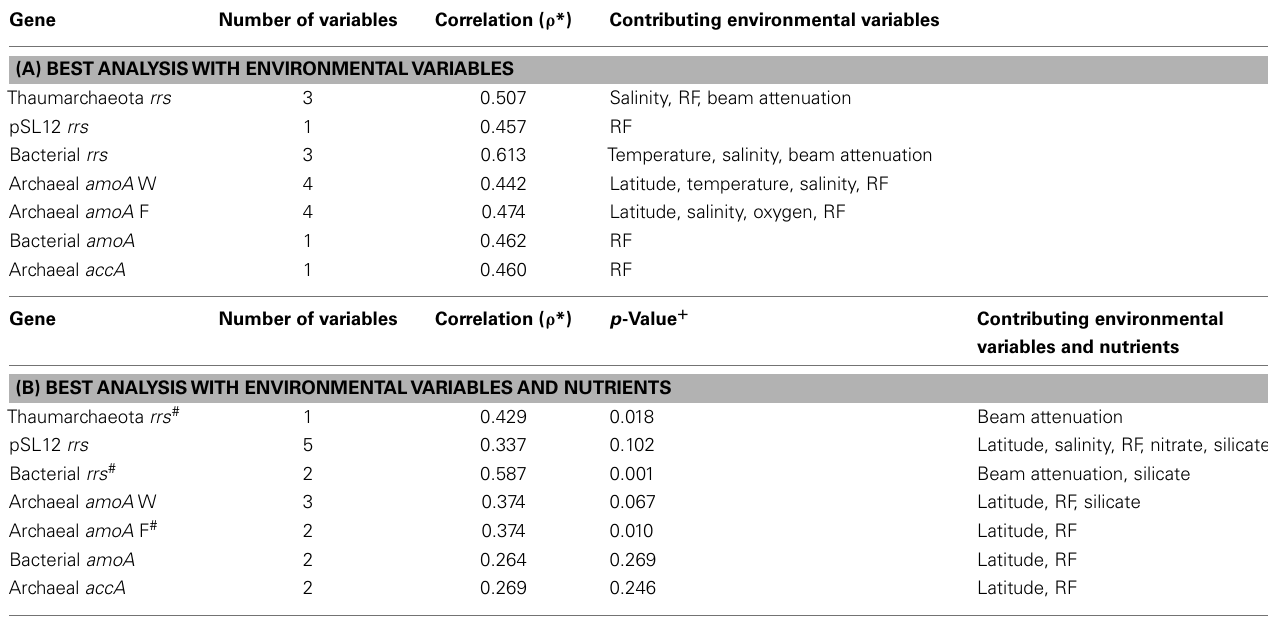
TableA7 | Results of BEST analysis comparing gene abundance to (A) environmental factors and (B) environmental factors and nutrients (only near-surface samples used with